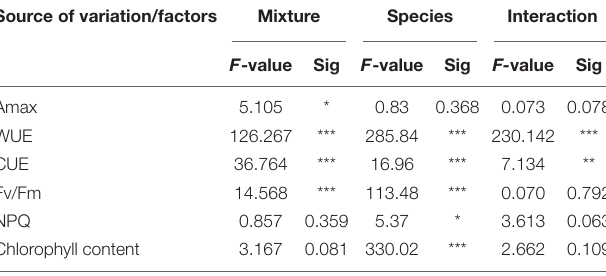
TABLE 2 | Results of two-way ANOVA on the effects of mixture and species on photosynthetic performance parameters. Source of variation/factors